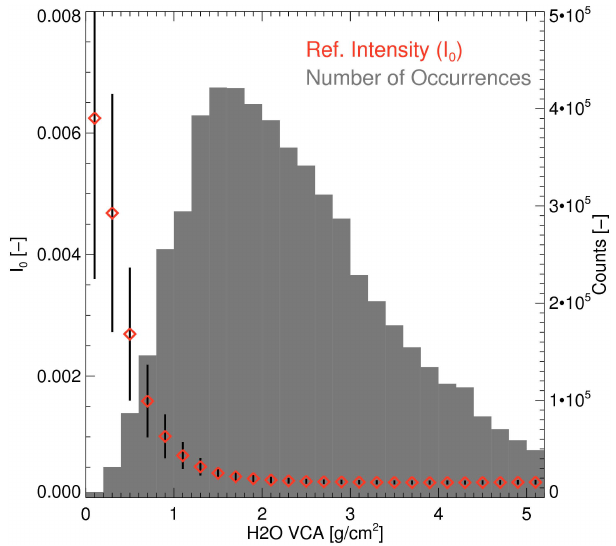
Fig. 2. Analysis of 1.4µm (1390nm–1410nm) radiances as mea- sured by SCIAMACHY for the years 2003–2009. The red diamonds show the reference intensity ( I 0 ) as a function of the water vapour vertical column amount (H 2 O VCA). The reference intensity is de- fined as the mean of the 40% lowest values of the (sun-normalised) radiances (corresponding to scenes with no clouds or very small ef- fective cloud cover). The black vertical lines are the corresponding standard deviations. The grey histogram shows the number of oc- currences as a function of the water vapour vertical column